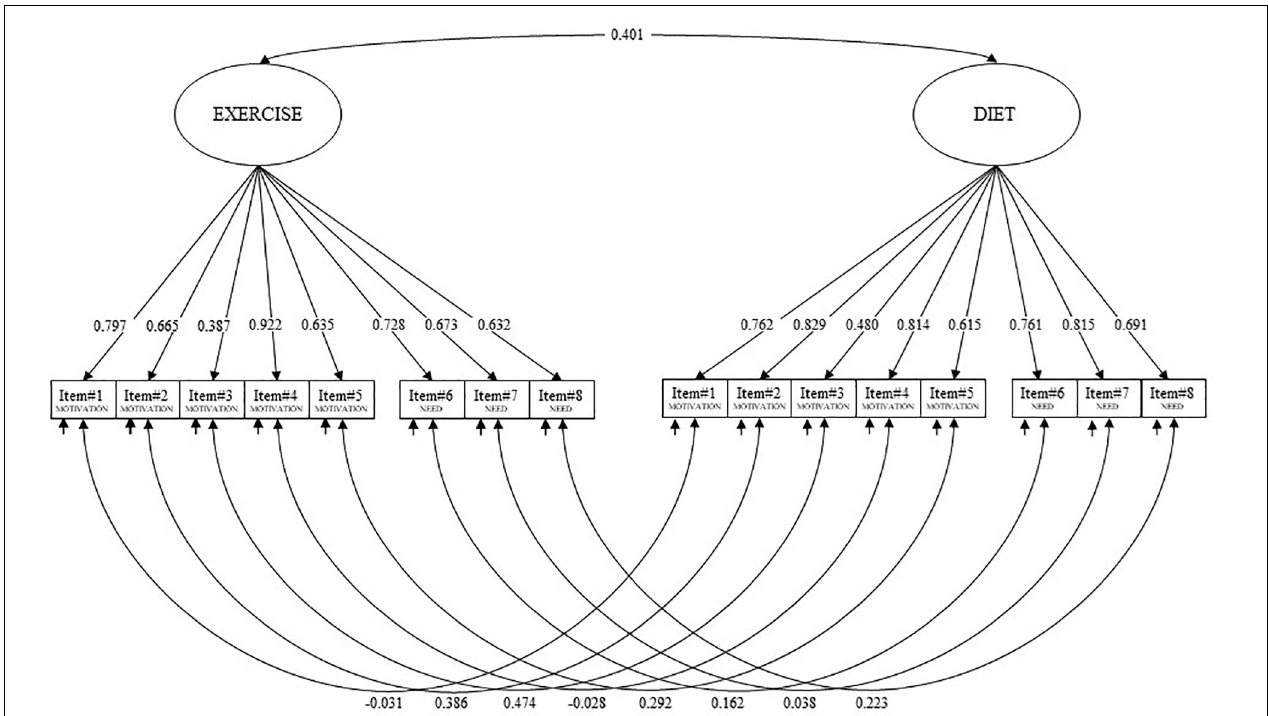
FIGURE 1 | Final confirmatory factor analysis (CFA) model of the Motivation to Exercise and Diet in Children (MED-C)